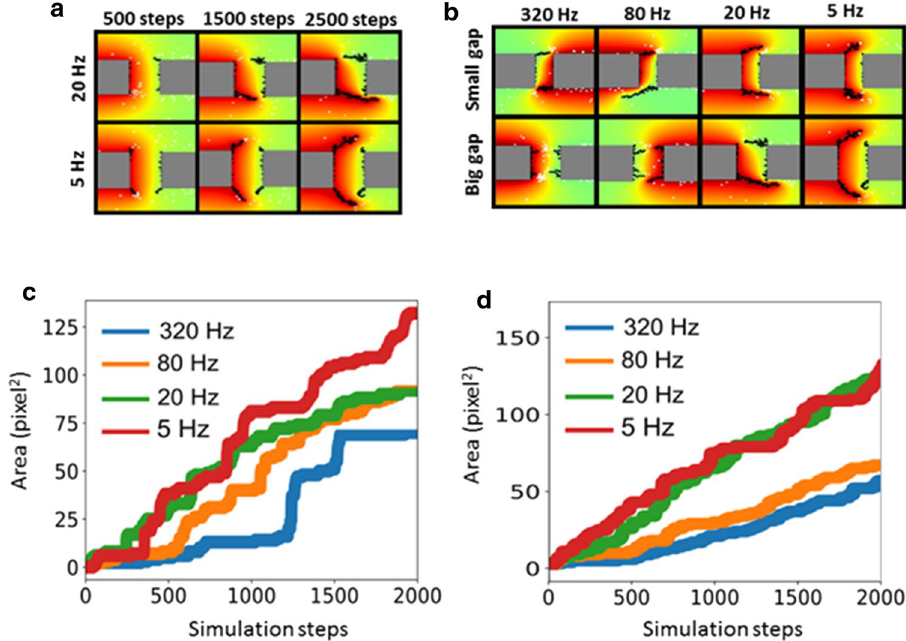
Fig. 6 Schematic representation of the mesoscale modeling for the dendritic growth ( a ). Flow chart of major steps used in the modeling ( b ). Modeling results with two V-shaped electrodes and a V-shaped against a flat electrode ( c )